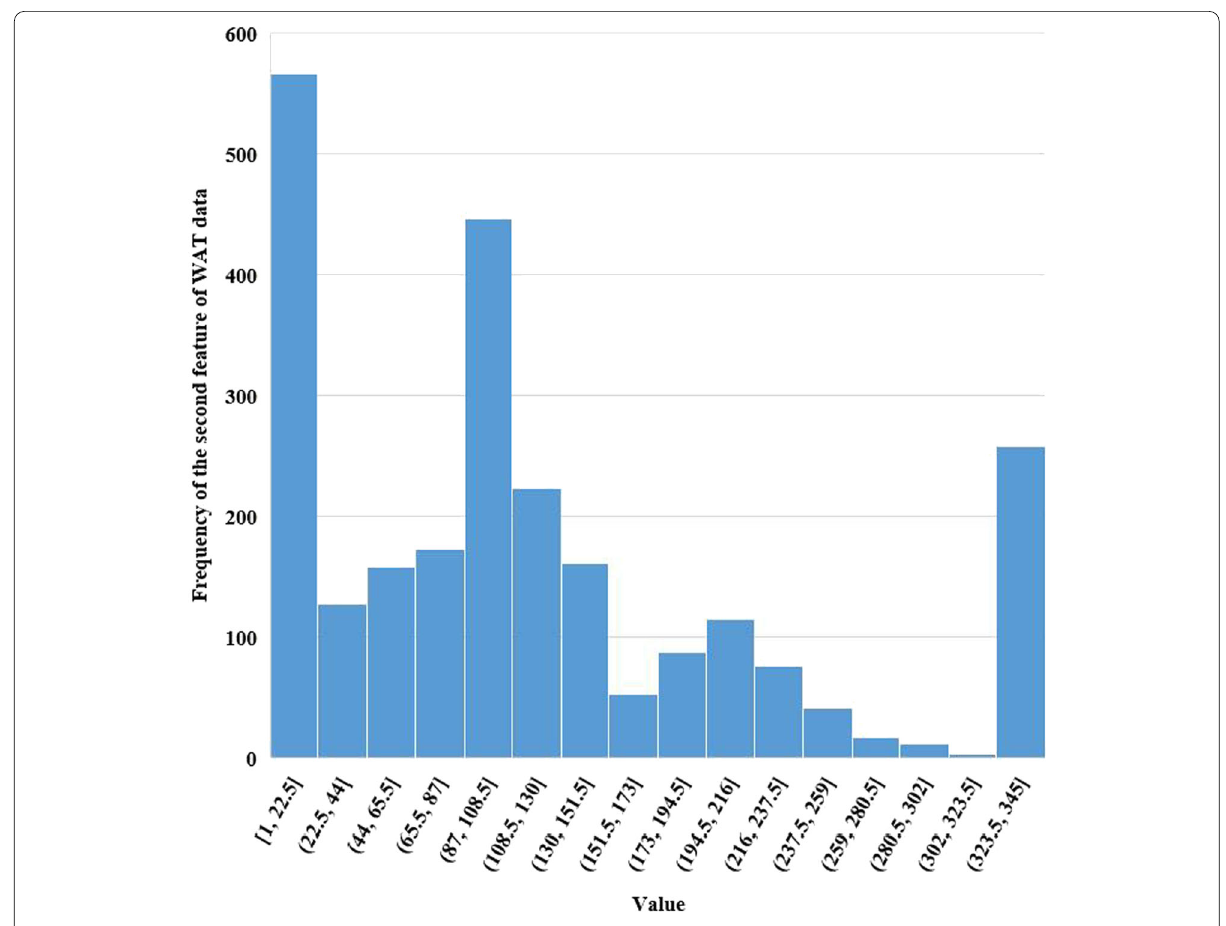
Figure 7 Data distribution of the second feature of WAT data after tailing operation